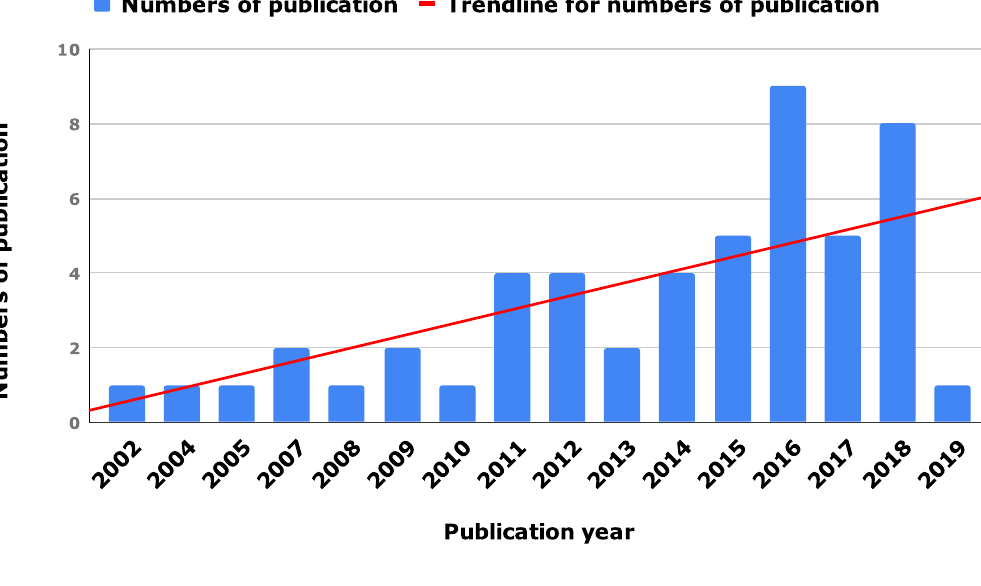
Figure 3. Distribution of article publications by